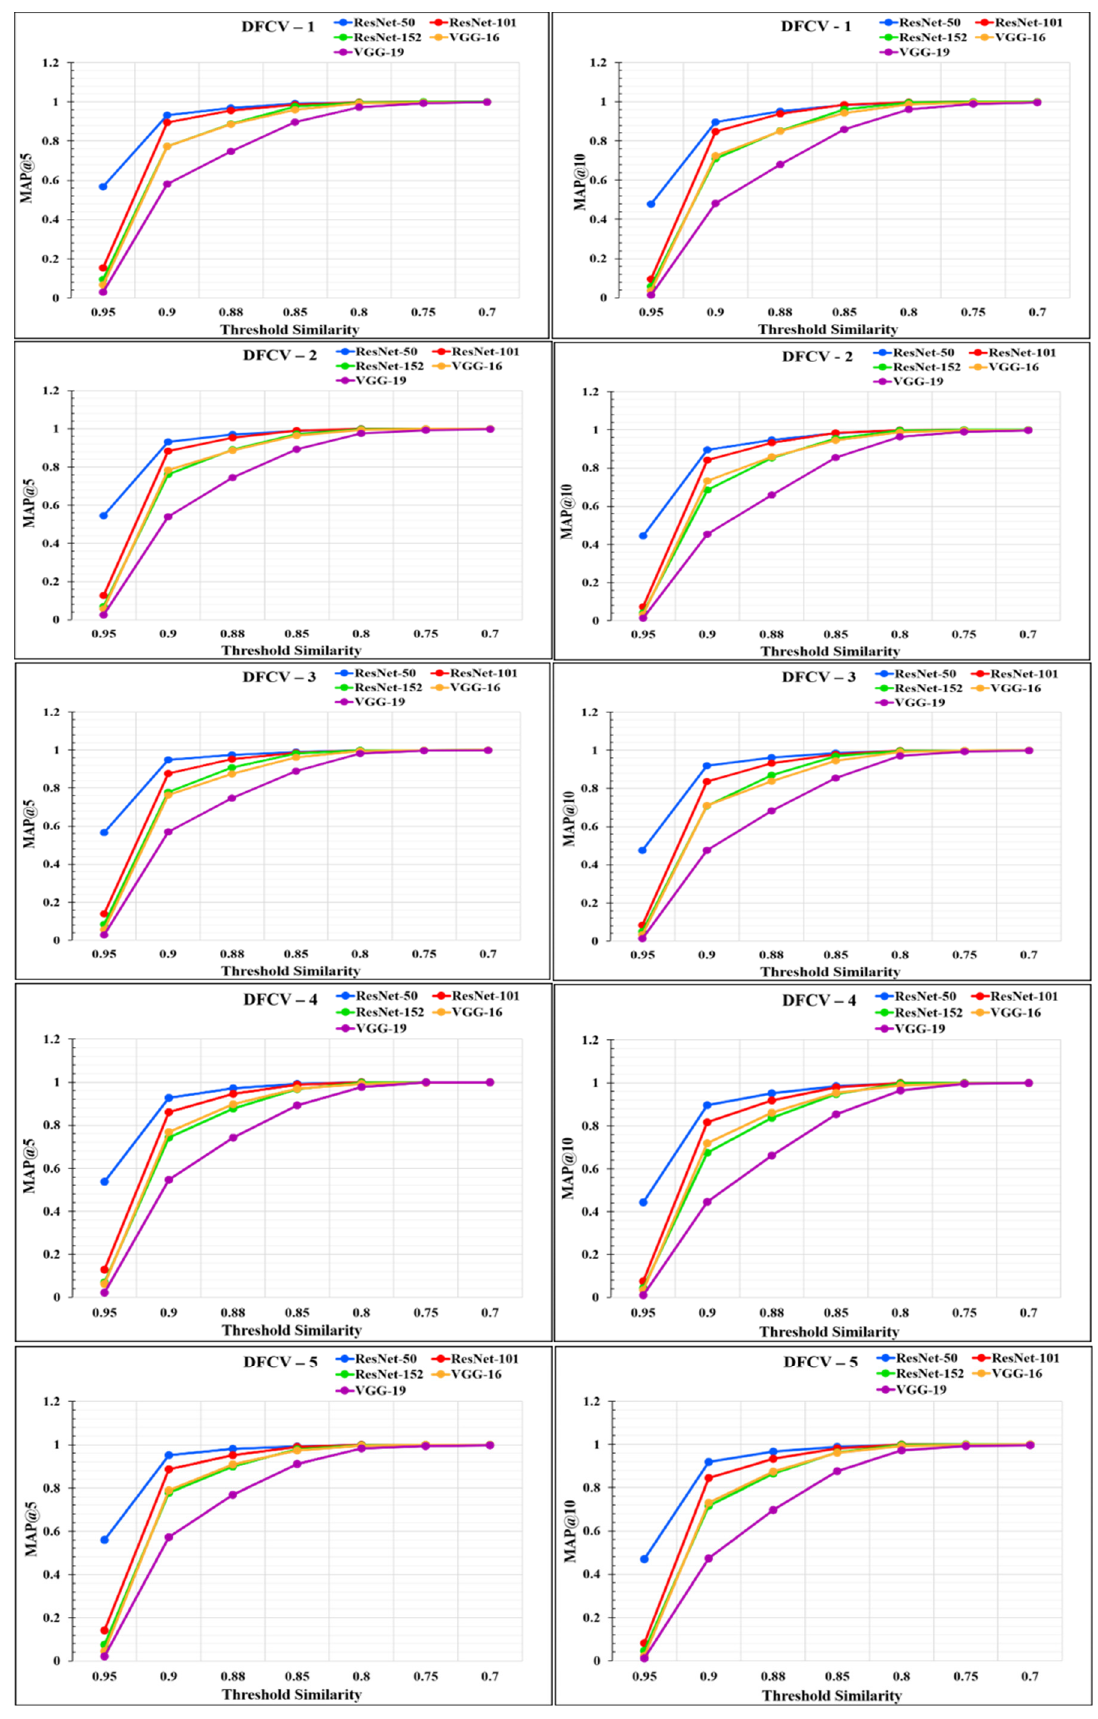
Figure 15. Mean Average precision @ k graphs for DFCV datasets for k = 5 and k = 10.